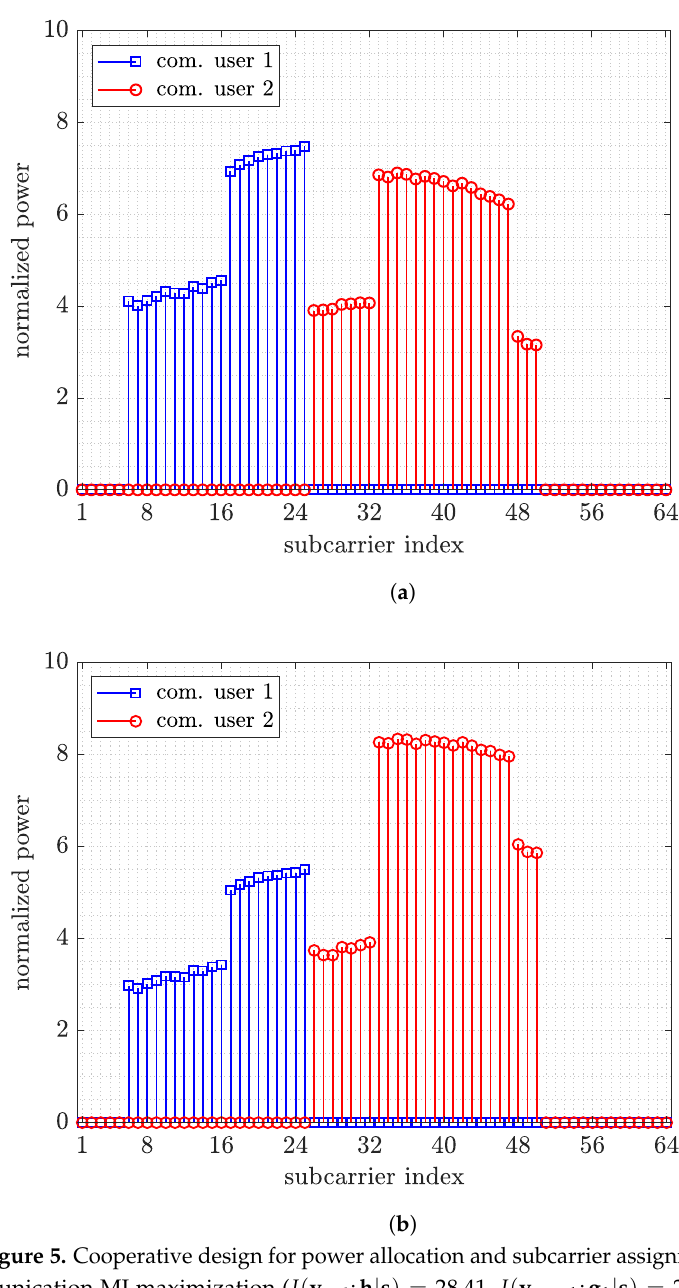
Figure 5. Cooperative design for power allocation and subcarrier assignment ( γ = 0.9). ( a ) Sum com- munication MI maximization ( I ( y rad ; h | s ) = 28.41, I ( y com,1 ; g 1 | s ) = 23.02, I ( y com,1 ; g 2 | s ) = 17.22). ( b ) Worst-case communication MI maximization ( I ( y rad ; h | s ) = 28.41, I ( y com,1 ; g 1 | s ) = 19.65, I ( y com,1 ; g 2 | s ) =